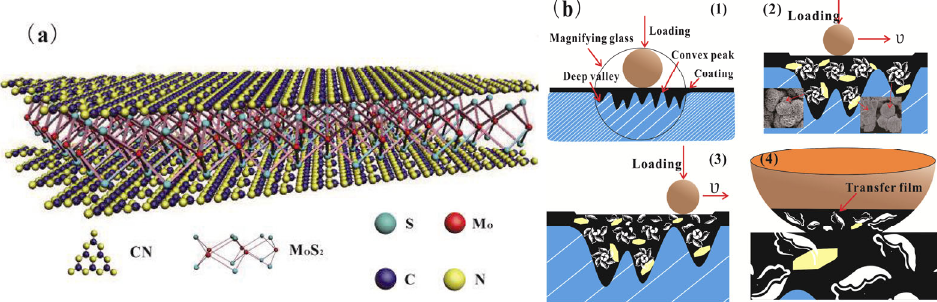
Fig. 8 (a) Molecular structure simulations and (b) lubrication mechanism models of CN/MoS 2